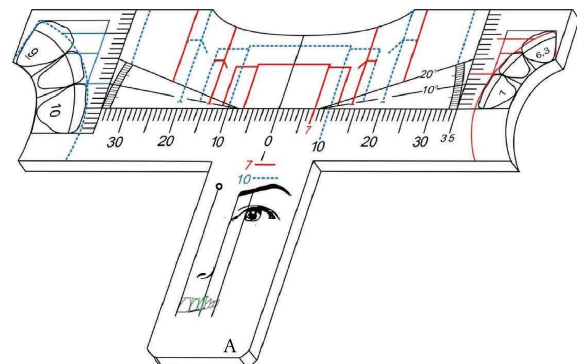
Figure 2: Perspective view illustration.